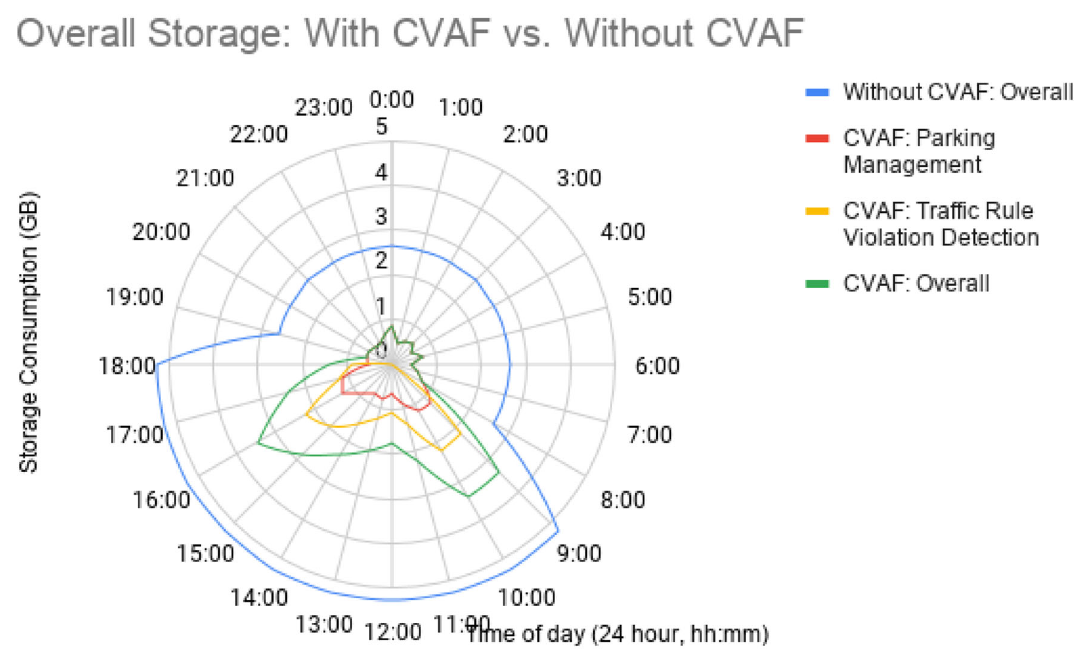
Improvement in S. no Application Final response Improvement in average response average response time during time during peak non-peak hours hours Parking Management Logging of vehicle entry/exit in the